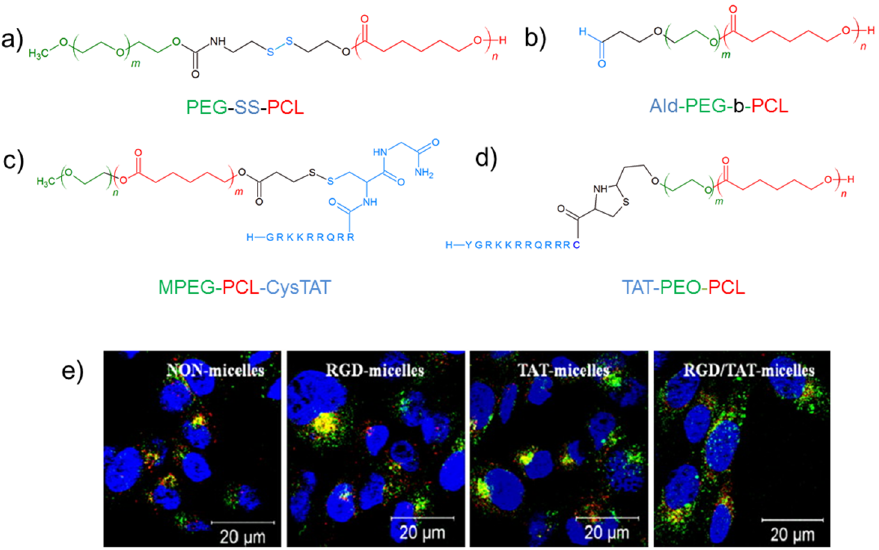
Figure 5. Chemical representation of some reported modified PEG-PCL polymers ( a – d ); ( e ) in vitro cellular distribution of the FAM-siRNA micellar formulations. FAM-siRNA was complexed in NON, RGD, TAT and RGD/TAT micelles. The incubation was with MDA435/LCC6-resistant cells for 4 h (siRNA 200 nm). The endosomes/lysosomes and nucleus were then stained with LysoTracker ® (red) and DAPI (blue), respectively (reproduced with permission from [106]). Inspired by these results, Zhu et al. designed cRGD- and TAT-modified cross-linka- ble micelles (cRGD/TAT CMs), in which the TAT peptide was shielded by relatively long